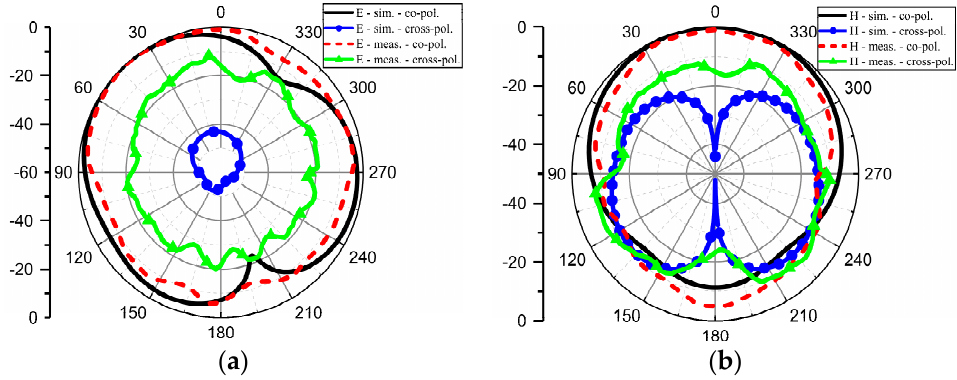
Figure 9. The comparison of simulated and measured normalized radiation patterns: ( a ) E-plane; ( b ) H-plane.